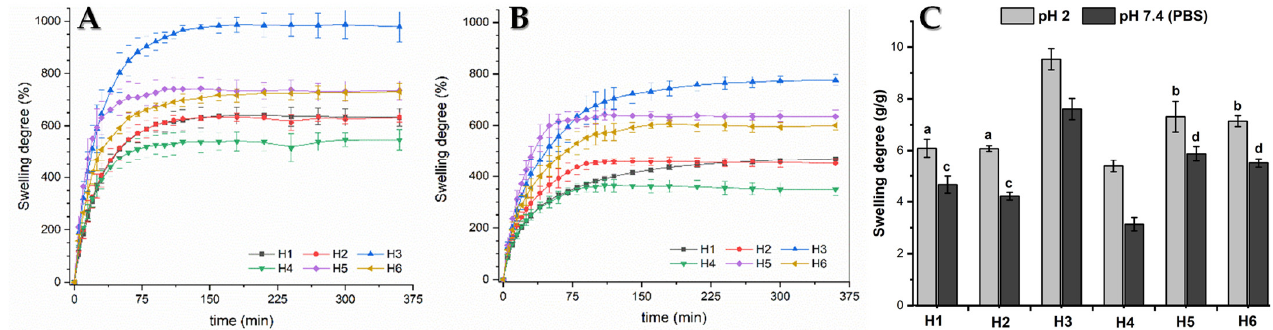
Figure 4. Swelling studies. ( A ) and ( B ) hydrogels’ profiles at pH 2.0 and 7.4, respectively. ( C ) Maximum swelling at equilibrium in more detail. There are no significant differences between two compared samples at same pH, for a and b ( p ≥ 0.05), or for c and d ( p ≥ 0.01).